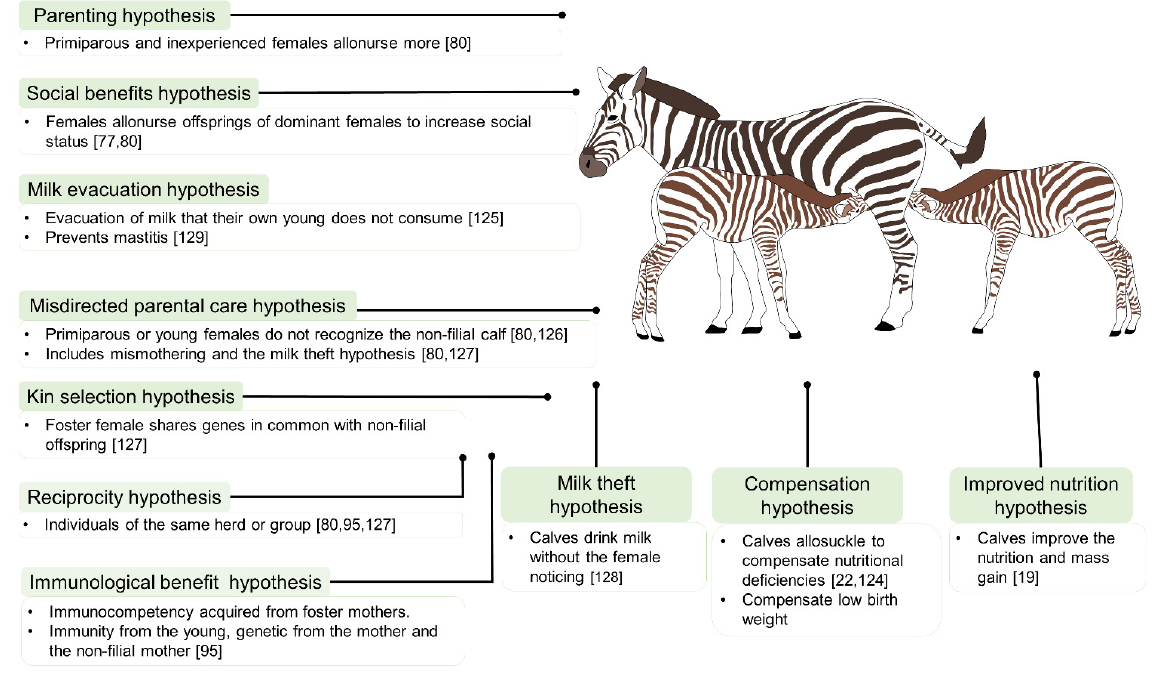
Figure 4. The main hypotheses explaining allonursing and allosuckling. Some of the hypotheses of these two cooperative maternal behaviors include genetic origins of the foster mother and the non-filial young, social and health benefits for the female, and advantages to the offspring to compensate and improve nutrition and